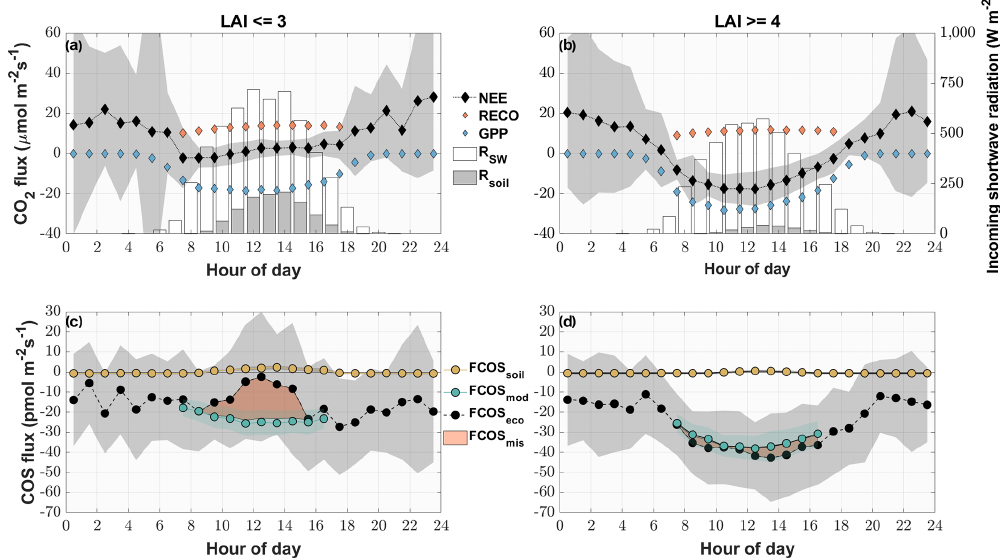
Figure 6. Mean diel variation in the measured and modeled CO 2 (a, b) and COS (c, d) fluxes for phases of low (LAI < = 3) (a, c) and high (LAI > = 4) LAI (b, d) from May to August. The diamonds depict the modeled gross primary productivity (blue), the modeled ecosystem respiration (orange) and the measured CO 2 ecosystem fluxes (black) in micromoles per square meter per second. The circles depict the modeled COS soil flux (yellow), the modeled COS ecosystem flux (turquoise) and the measured COS ecosystem fluxes (black) in picomoles per square meter per second. The red area depicts the difference between the measured ecosystem flux and the sum of the modeled fluxes. The gray areas depict the ± 1 standard deviation of the mean for all the measured fluxes. The white bars depict the diel mean total incoming shortwave radiation (Wm − 2 ), while the gray bars indicate the diel mean shortwave radiation reaching the soil surface.